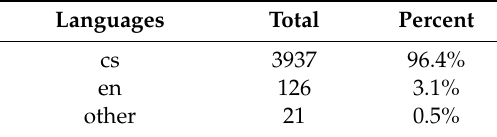
Table A11. Primary languages (cz).